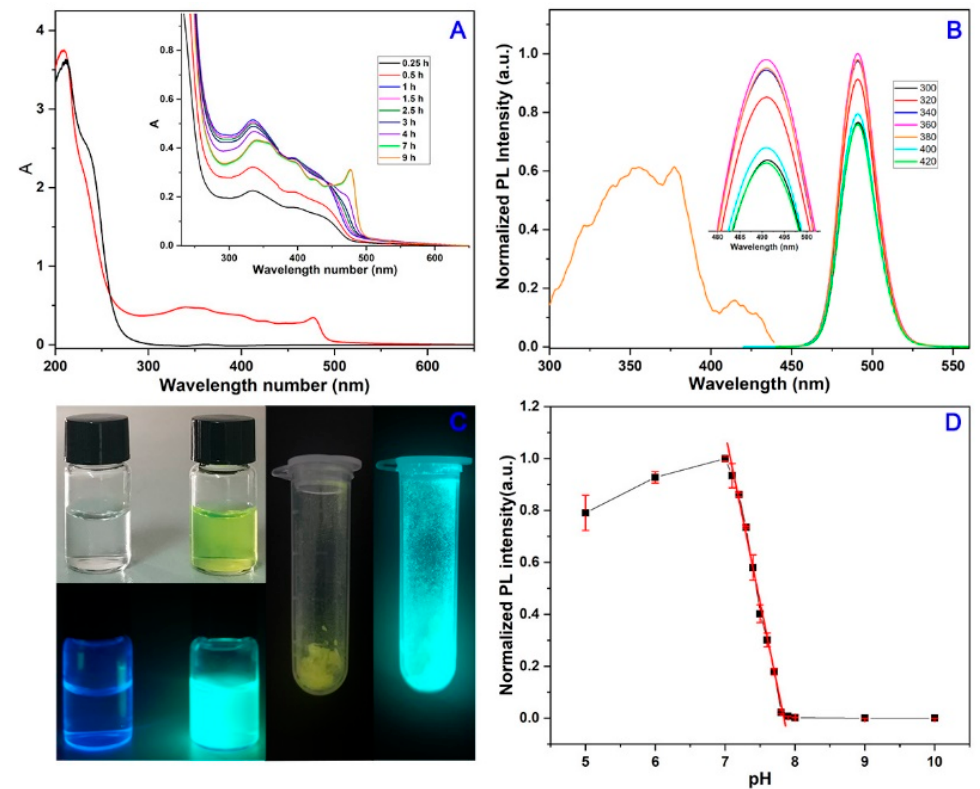
Figure 3. ( A ) UV-vis absorption spectra of Au 4 NCs (black) and Au NWs (red). ( B ) Fluorescence spectra at different excitation wavelengths and excitation spectrum of Au NWs. ( C ) Photographs taken under visible light and UV light of Au 4 NCs, Au NWs in water and Au NWs powder. ( D ) The plot of the fluorescence intensity of Au NWs (excitation at 360 nm) recorded at 485 nm versus the pH value.